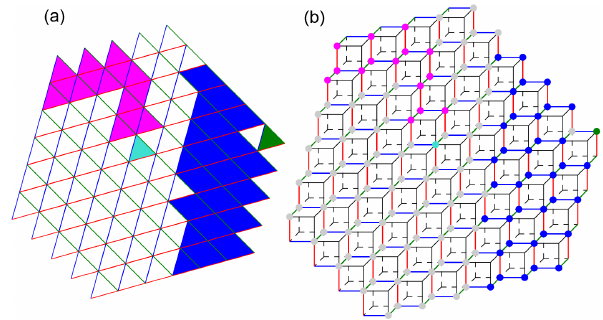
Figure 10. Same as in Fig. 9 but for edge connectivity. A set of triangles on the triangular grid are edge connected if any two of the vertices on the cubical grid can be connected by a sequence of vertices such that two subsequent ones are connected by an edge of a